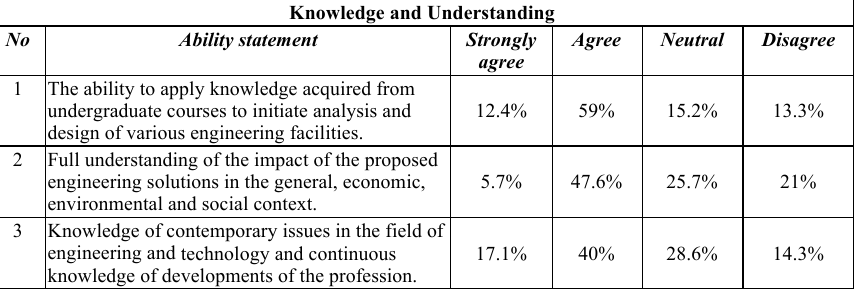
Table 1. Graduates feedback on Knowledge and Understanding learning